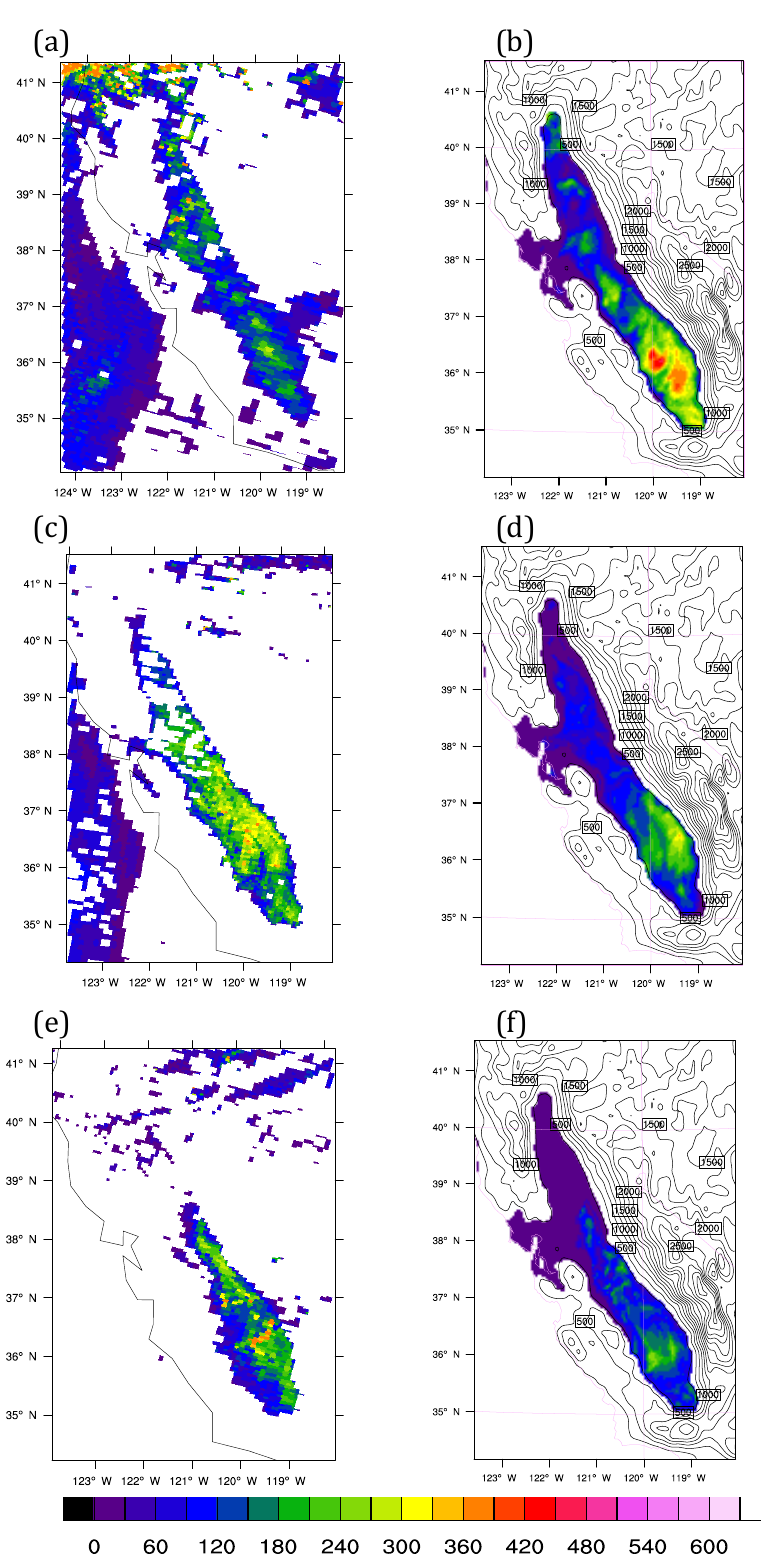
Figure 7. Liquid water path (LWP) (gm − 2 ) from MODIS Level 2 cloud products ( a , c and e ) and from the SOWC model with aerosol feedback on and modified cloud–radiation scheme (S_ARon_CRmod; b , d and f ). (a) and (b) are at 19:00UTC on 16 January 2011. (c) and (d) are at 18:00UTC on 17 January 2011. (e) and (f) are at 19:00UTC on 18 January 2011. Contours in (b) , (d) and (f) are terrain heights in